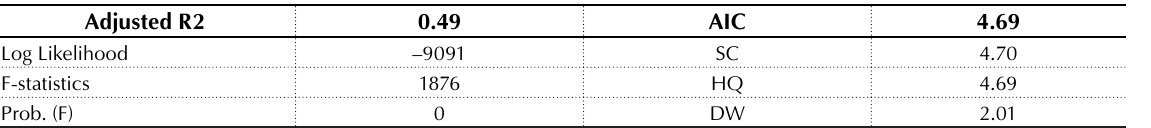
Table 2. Robustness measures